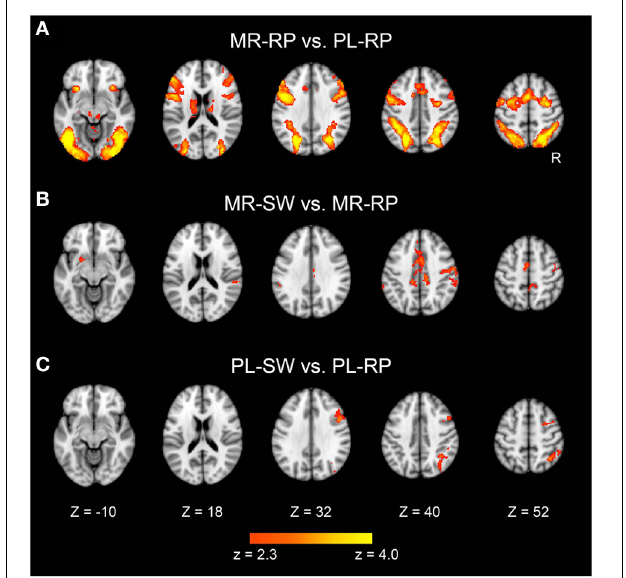
FIGURE 3 | Statistical significance maps for the contrasts Mirror-Repeat minus Plain-Repeat (A), Mirror-Switch minus Mirror-Repeat (B), and Plain-Switch minus Plain-Repeat (C) trials in the pre-training session ( P < 0 . 05 cluster size corrected). The color scale reflects statistical significance as shown by the color bar to the bottom (above Z > 2 . 3 uncorrected). Maps are displayed as transverse sections and are overlaid on thetopofthestandardanatomicalimage.Thelevelsofsectionsareindicated by the Z coordinates of MNI space. R,